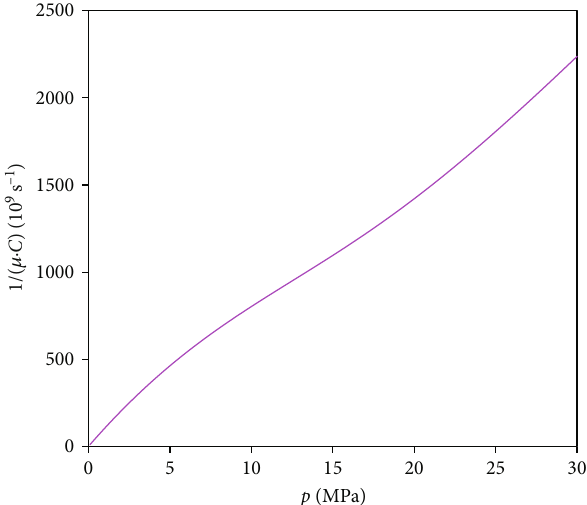
ð p Þ vs. p for the normal pressure p